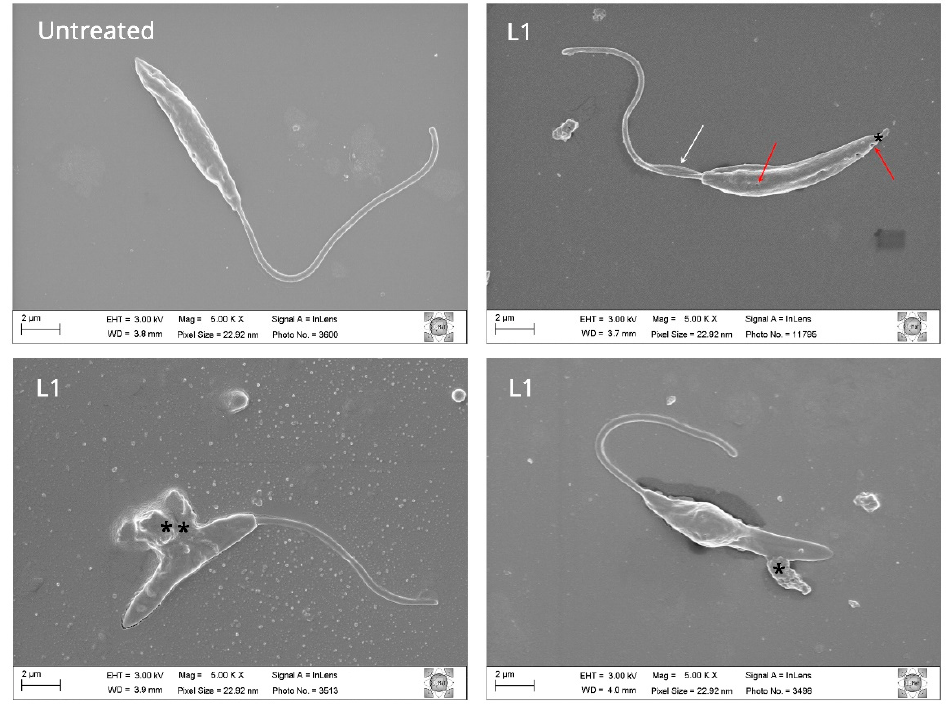
Figure 5. Effect of L1 compound on Leishmania amazonensis promastigote. Untreated parasite and promastigote forms treated for 24 h with L1 compound at concentration 1.24 µM were observed by scanning electron microscopy and images were acquired. Treated parasites evidence morphological changes in the membrane with (*) with possible extravasation of cell content (**), cytoskeleton modification by deforming of parasite's flagellum shape (white arrow), and pores (red arrow).